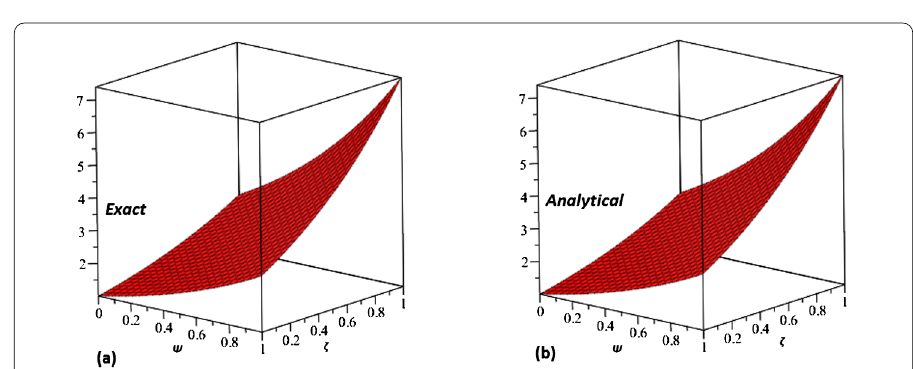
Figure 5 The ν -solution graph of example 2, ( a ) exact solution and ( b ) ETDM solution at δ = 1